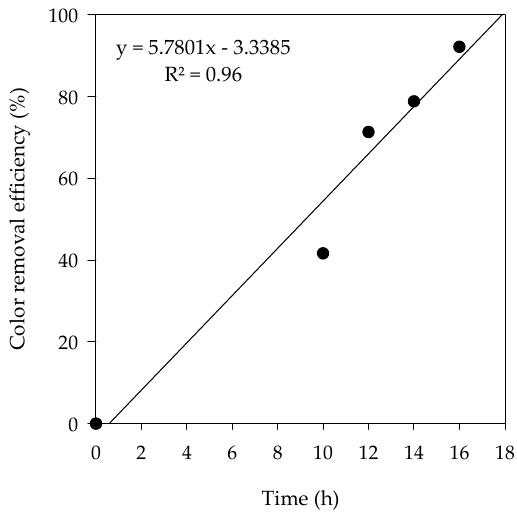
Figure 8. Time lapsed color removal efficiency in electrochemical treatment.